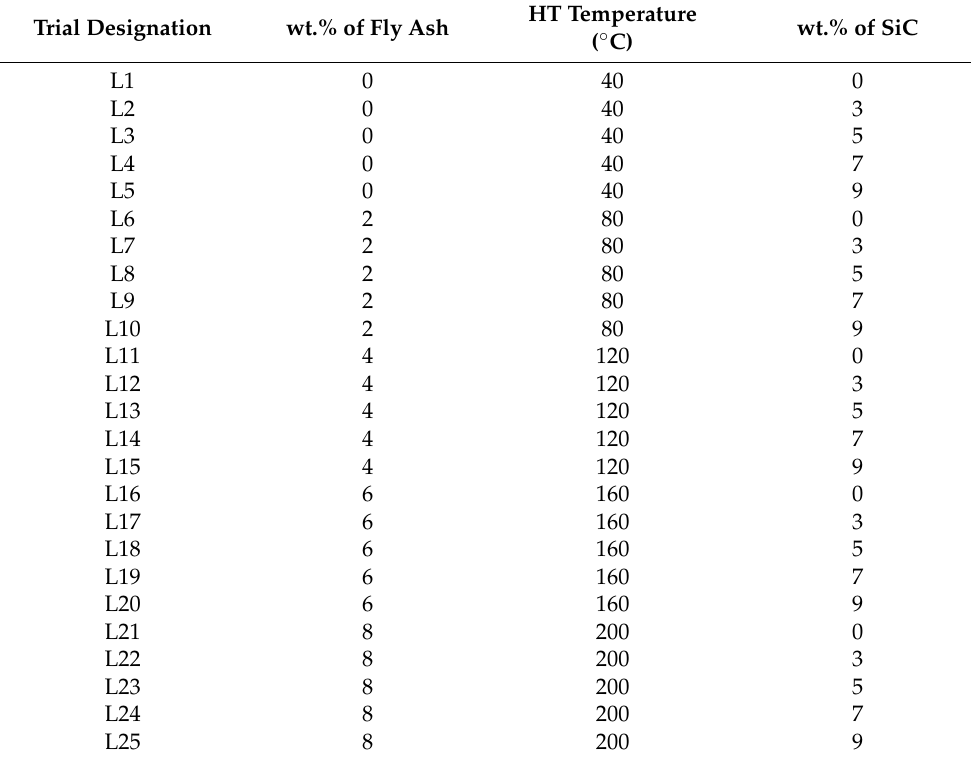
Table 5. Experimental conditions for different trials.